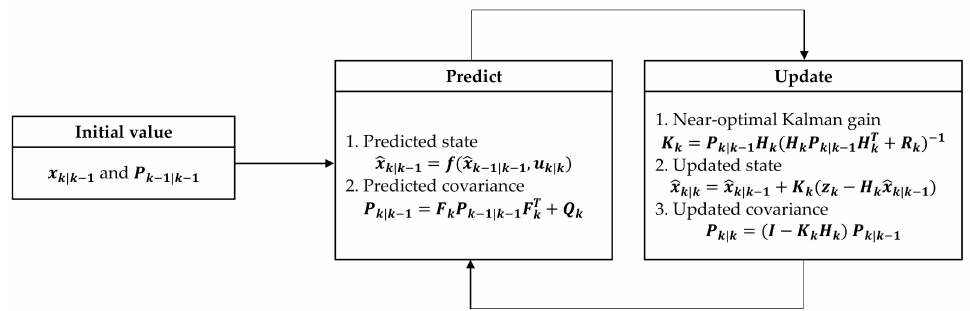
Figure 3. Extended Kalman filter